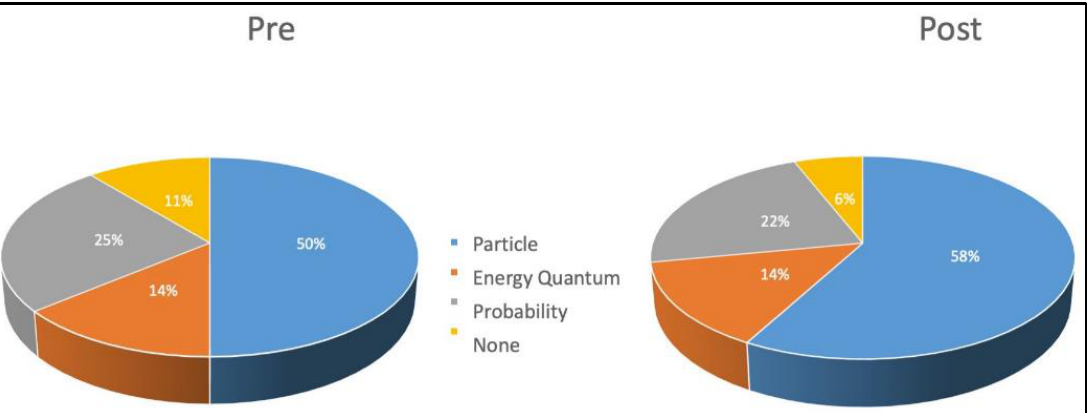
Figure 5. Students‘ reasoning for the explanation of the beam - splitter experiment, before (“pre”) Figure 5. Students’ reasoning for the explanation of the beam-splitter experiment, before (“pre”) and and after (“post”) they were engaged with the experiment. after (“post”) they were engaged with the